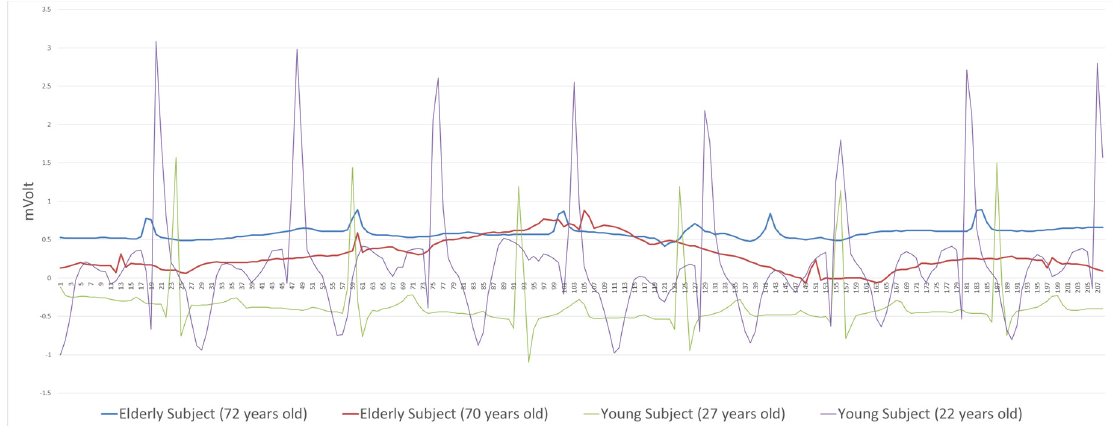
Figure 3. Sample ECG original signals that exhibit big differences between young and elderly subjects. The QRS amplitude of elderly people tends to be weaker than that of young